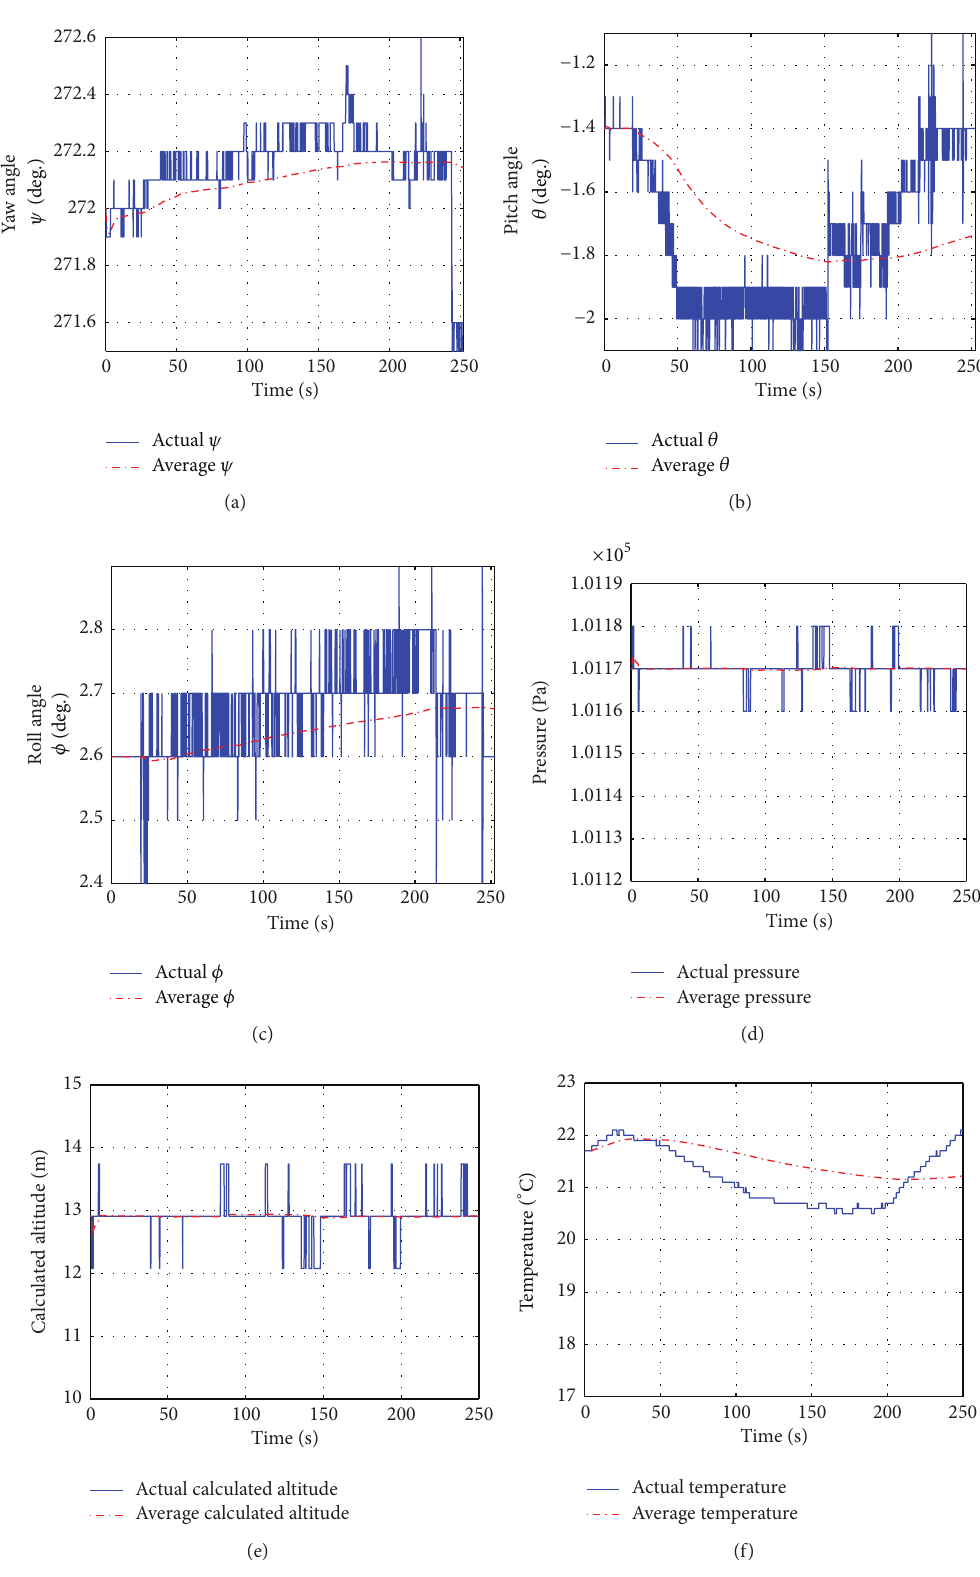
Figure 14: Ground test signals playback for the proposed UAV platform via GSM data communication